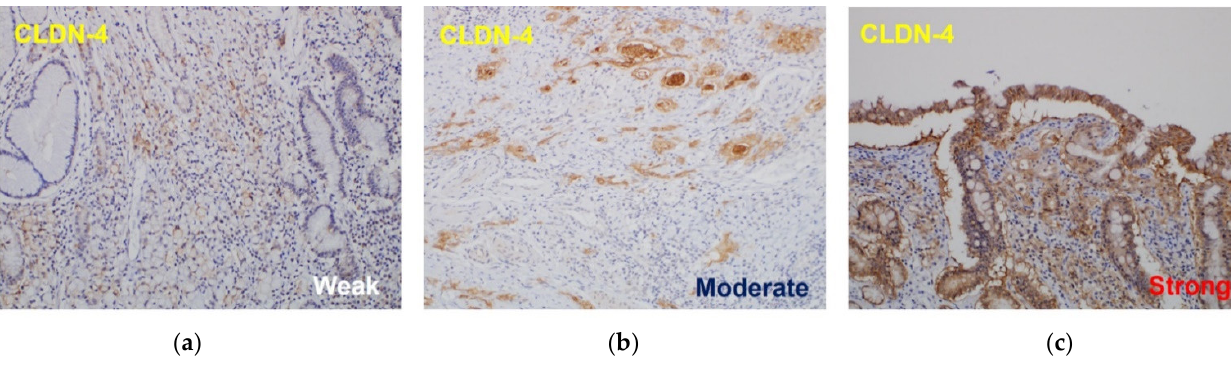
Figure 1. The results of claudin-4 expression in immunohistochemical staining: ( a ) weak expression of CLDN-4, ( b ) moderate expression of CLDN-4, ( c ) strong expression of CLDN-4. CLDN, claudin.